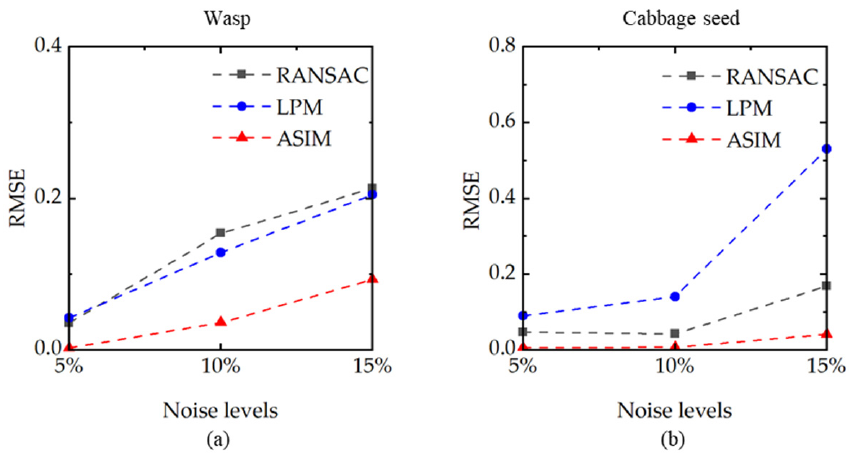
Figure 6. RMSE at different noise levels (5%, 10%, and 15%) are corrected by RANSAC, LPM, and ASIM. ( a ) The test sample is wasp. ( b ) The test sample is cabbage seed. The proposed method (red curve) achieves the most stable results.